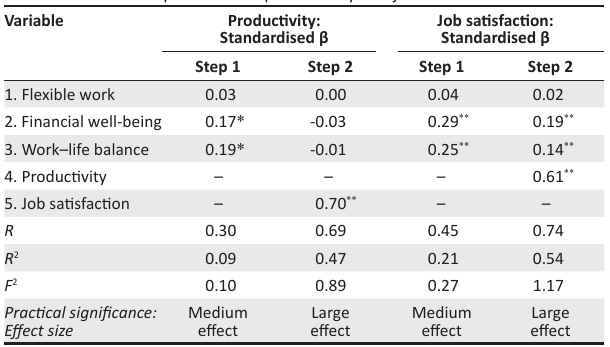
TABLE 3: Regression analysis with flexible work, financial well-being and work–life balance as predictors of productivity and job satisfaction.